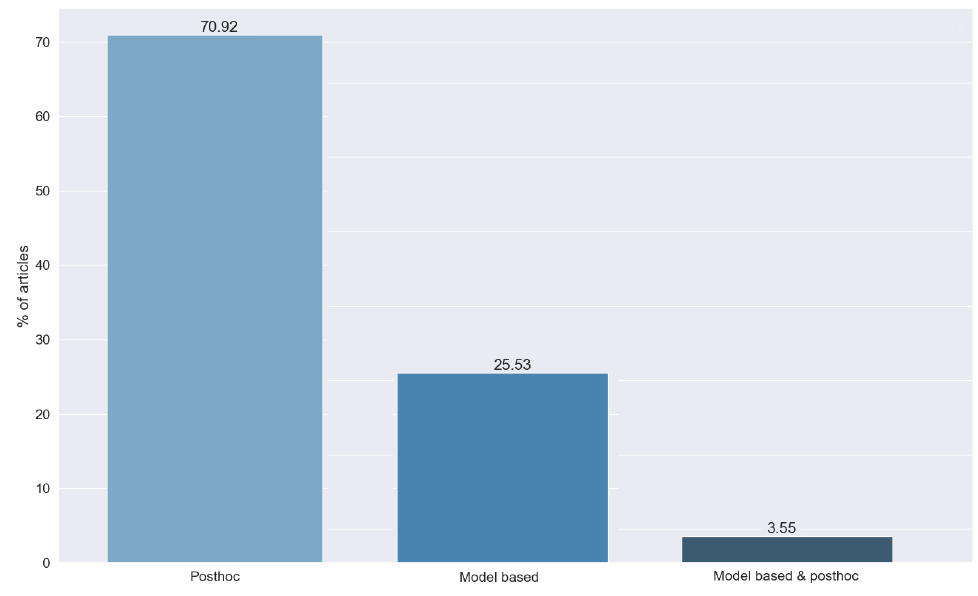
Figure 13. Type of method used, obtained from the answers to RQ6. Vertical axis indicates the percentage of articles for each